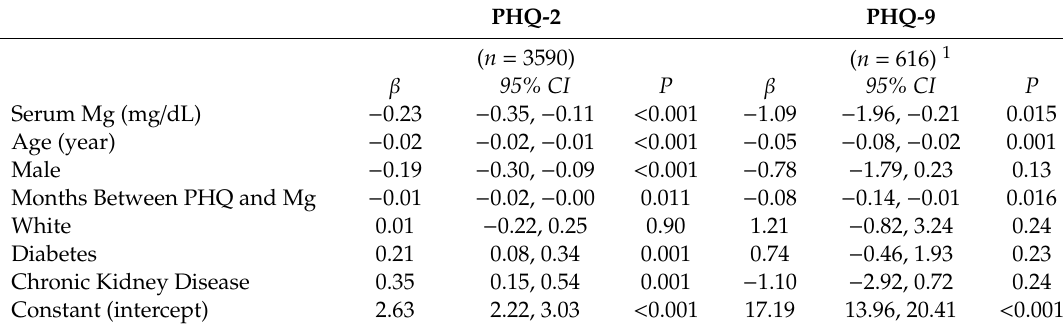
Table 2. Multivariate regression analyses.